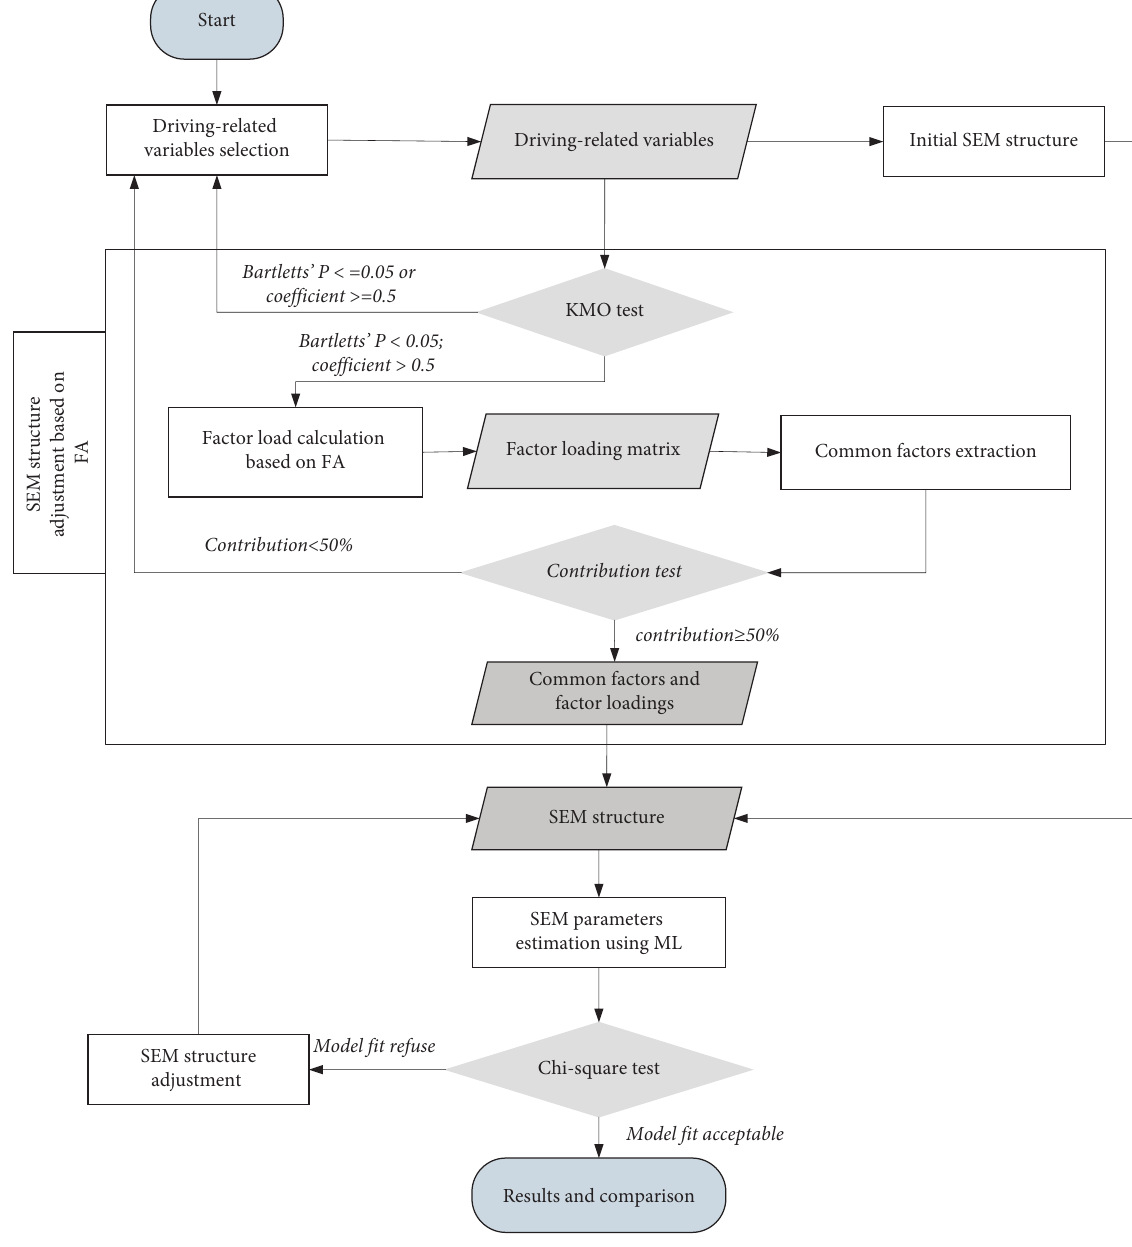
Figure 2: Flowchart of the correlation